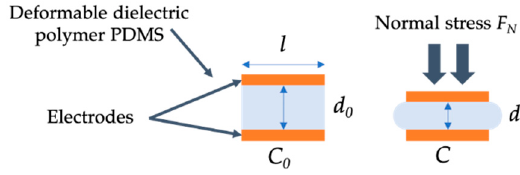
Figure 1. Principle of operation of the flexible normal pressure capacitive sensor.